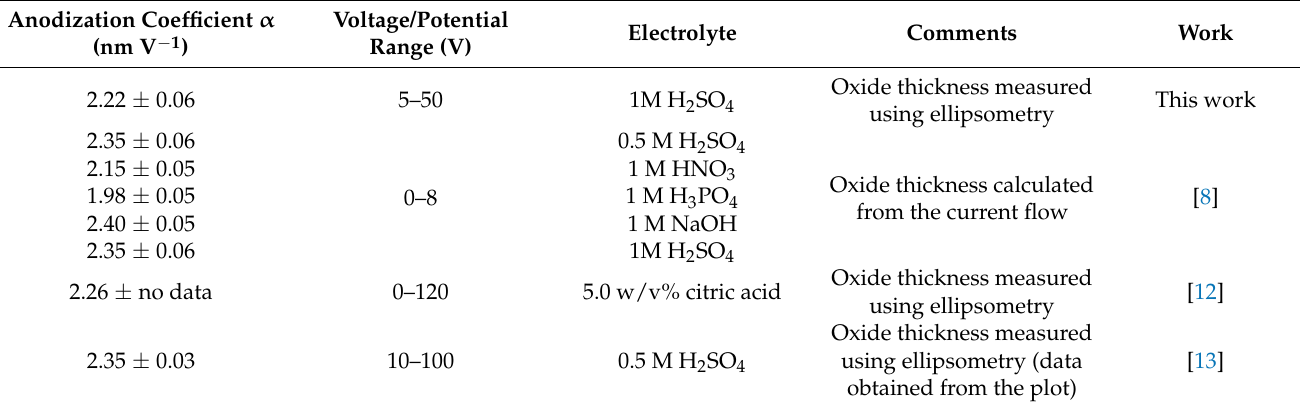
Table 5. Anodization coefficient α for niobium